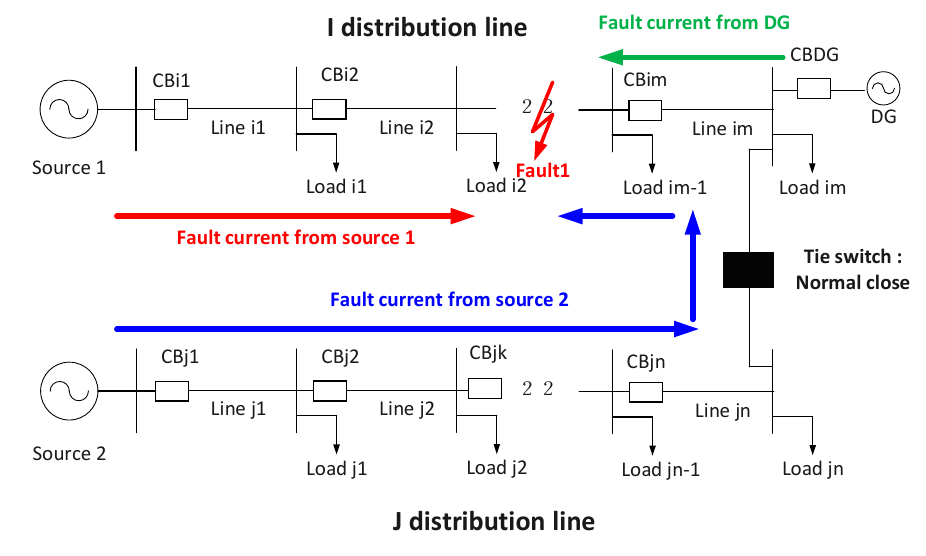
Figure 1. Loop-type distribution system model with DG.